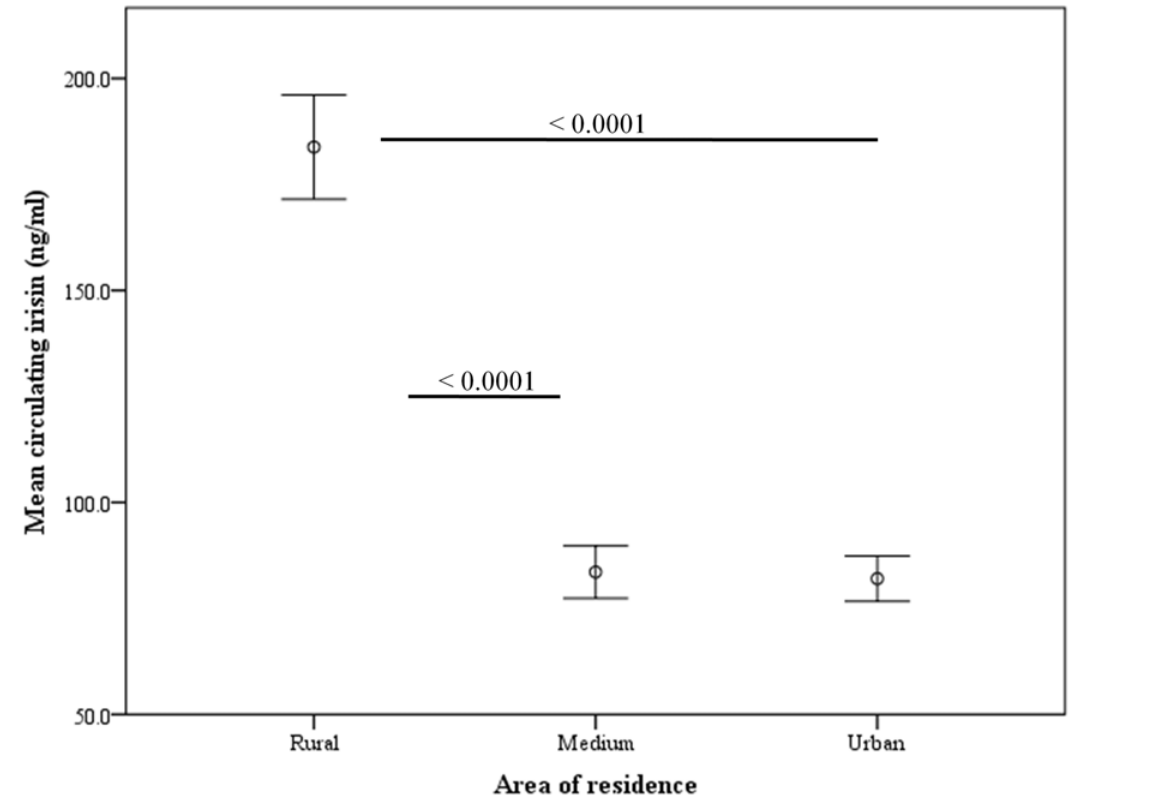
Fig 2. Circulating irisin levels according to the area of residence (n = 428) (only significant differences are shown).